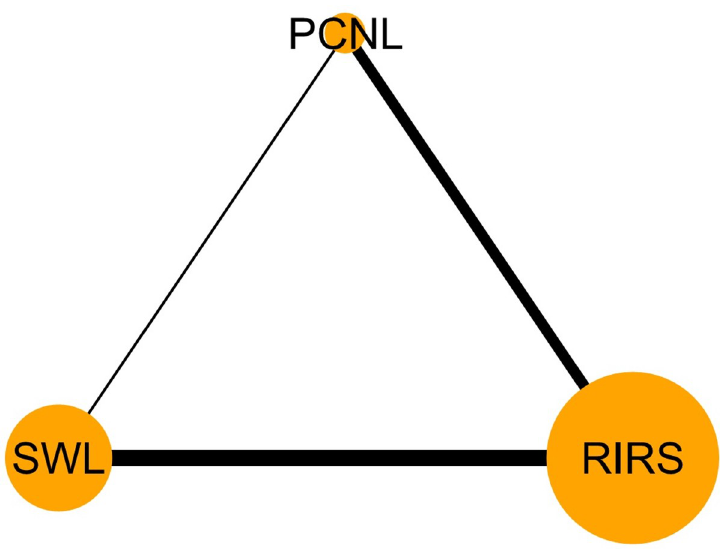
Fig 2. Network plots for included studies. Six studies compared PCNL versus SWL. Six studies reported outcomes between PCNL and RIRS. Eight studies compared outcomes between RIRS and SWL. Four studies demonstrated the comparison for PCNL, SWL, and RIRS.